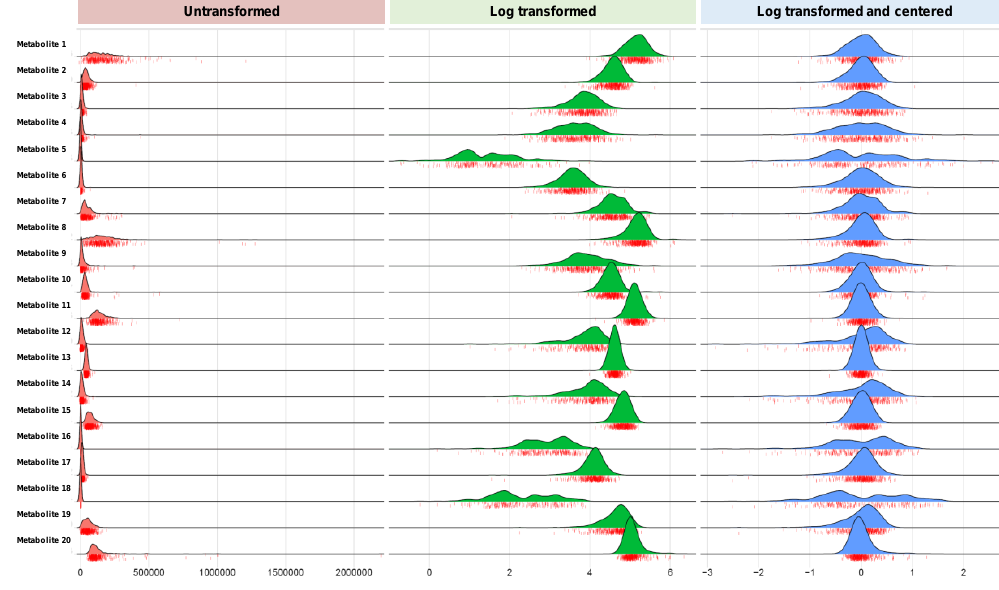
Figure 1. Metabolite data transformation and centering. A frequently used approach for managing metabolite data collected in a large human cohort study involves log transforming each metabolite measures and centering the data on plate median to account for batch to batch variation. Interestingly, variable transformation can reveal multi-modal